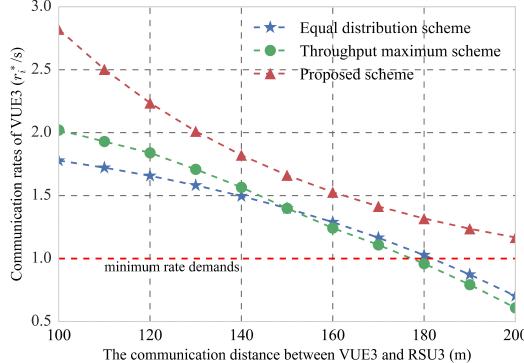
Figure 7. The comparison between the proposed method with existing methods on